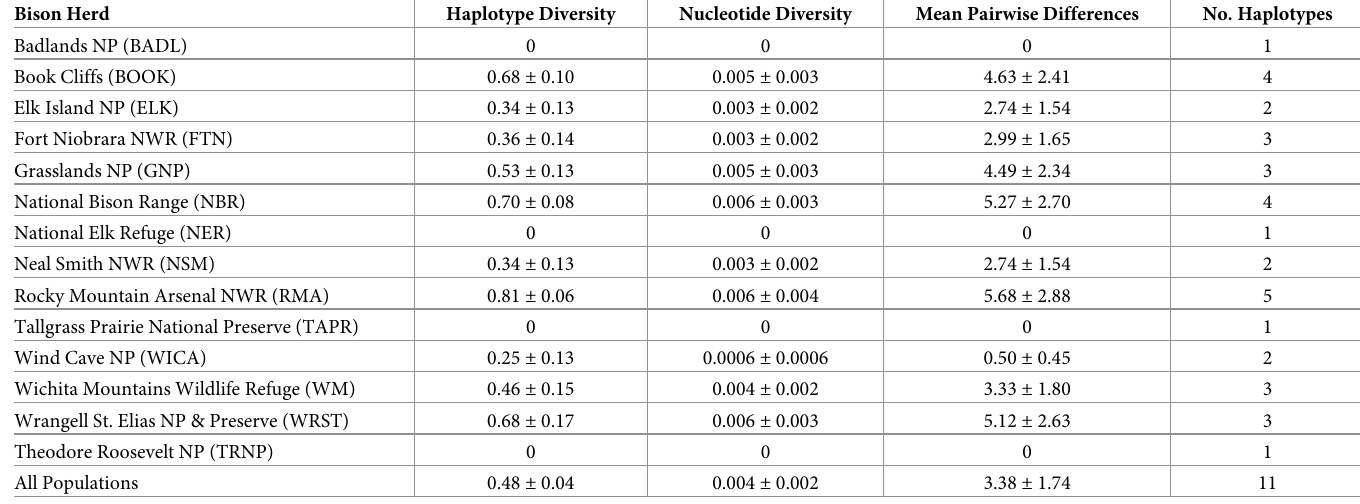
Table 2. Summary population statistics of 14 U.S. Department of Interior and Parks Canada Agency bison herds, and all the herds assembled as a whole